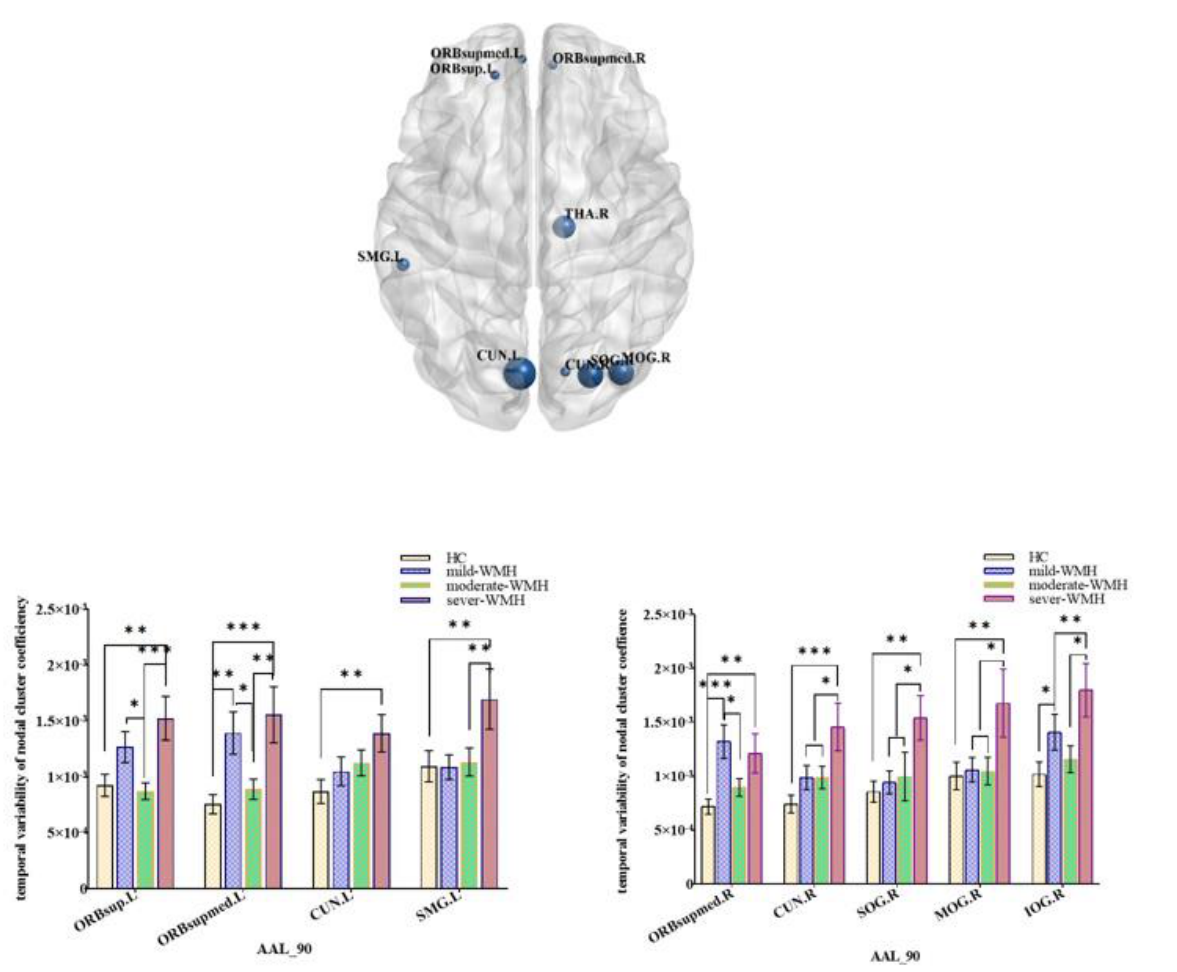
Figure 2. Group comparisons of the temporal variability of nodal efficiency. Right rolandic opercu- lum (ROL.R), right orbital part of superior frontal gyrus (ORBsup.R), right medial orbital part of superior frontal gyrus (ORBsupmed.R), right temporal pole: superior temporal gyrus (TPOsup.R), left rolandic operculum (ROL.L), and left postcentral gyrus (PoCG.L). ** significant at 0.01 level, and * significant at 0.05 level (2-tailed).